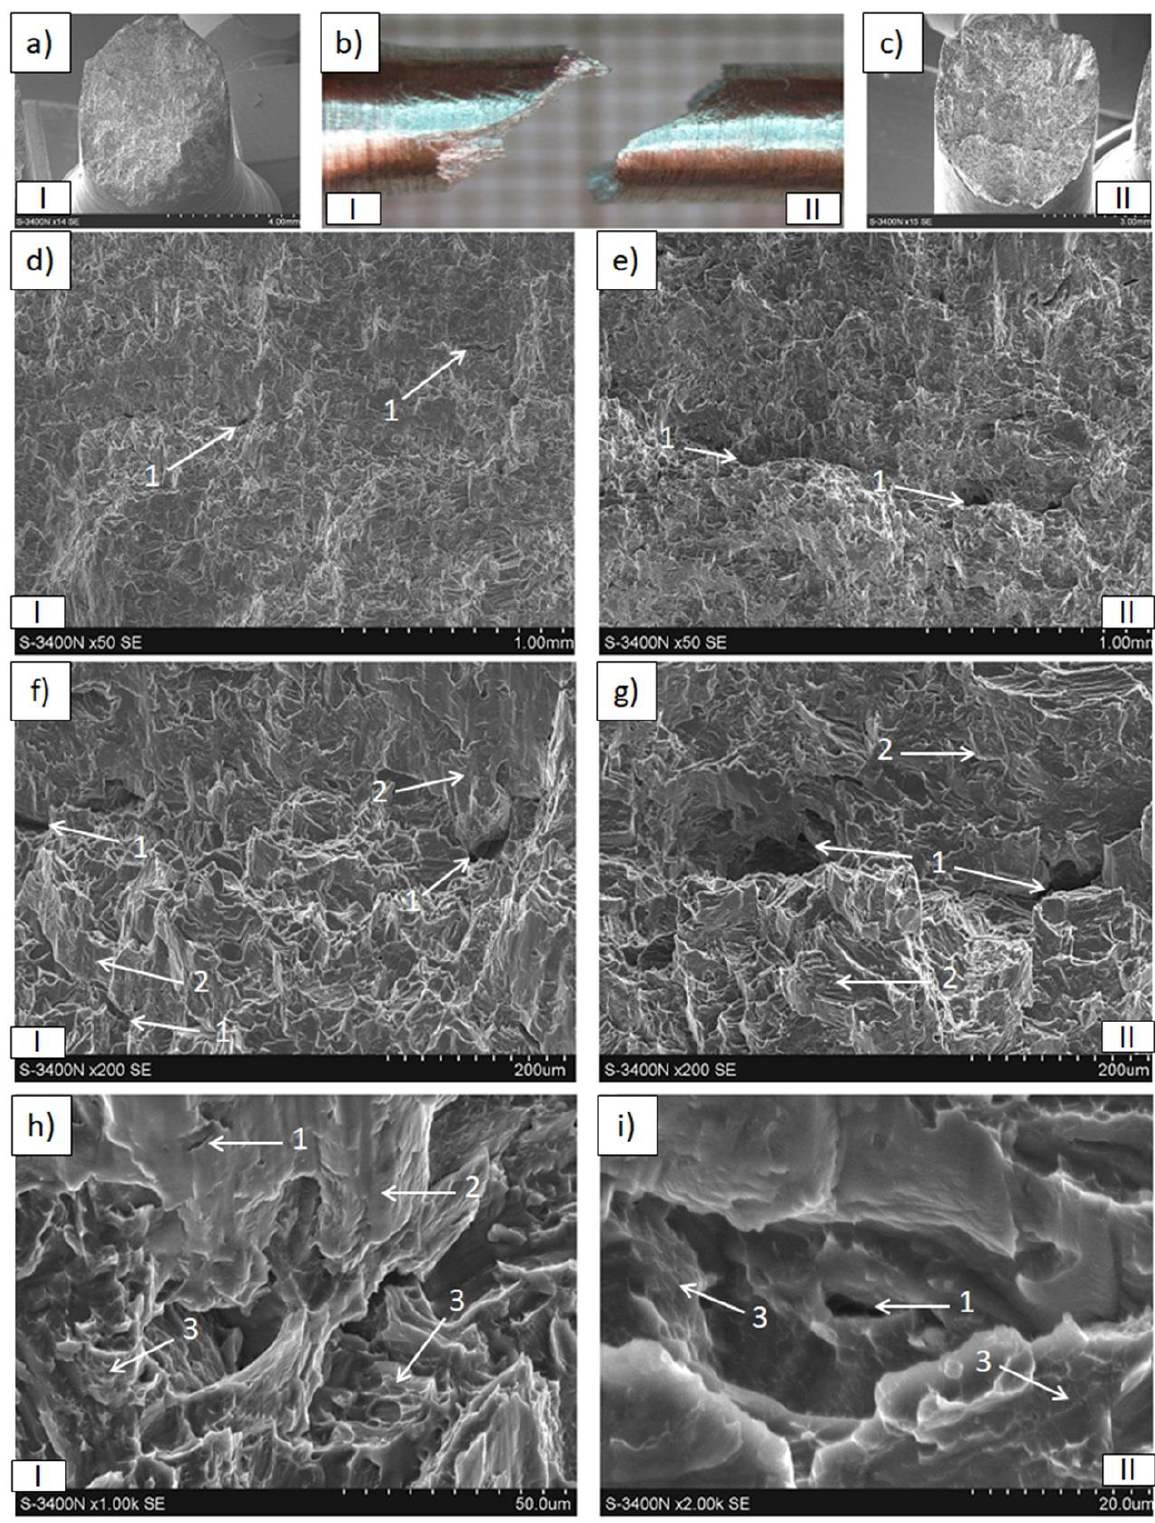
Figure 13. Decohesion effects in Mg(C) rod after tensile strength test. View of sample, fracture of quasi-brittle type with approx. 45° angle ( a – c ). SEM micrographs of fracture surface ( d – i ) with cracks perpendicular to extrusion direction (1), cleavage metal decohesion (2), and dimples of plastically deformed α -Mg (3).